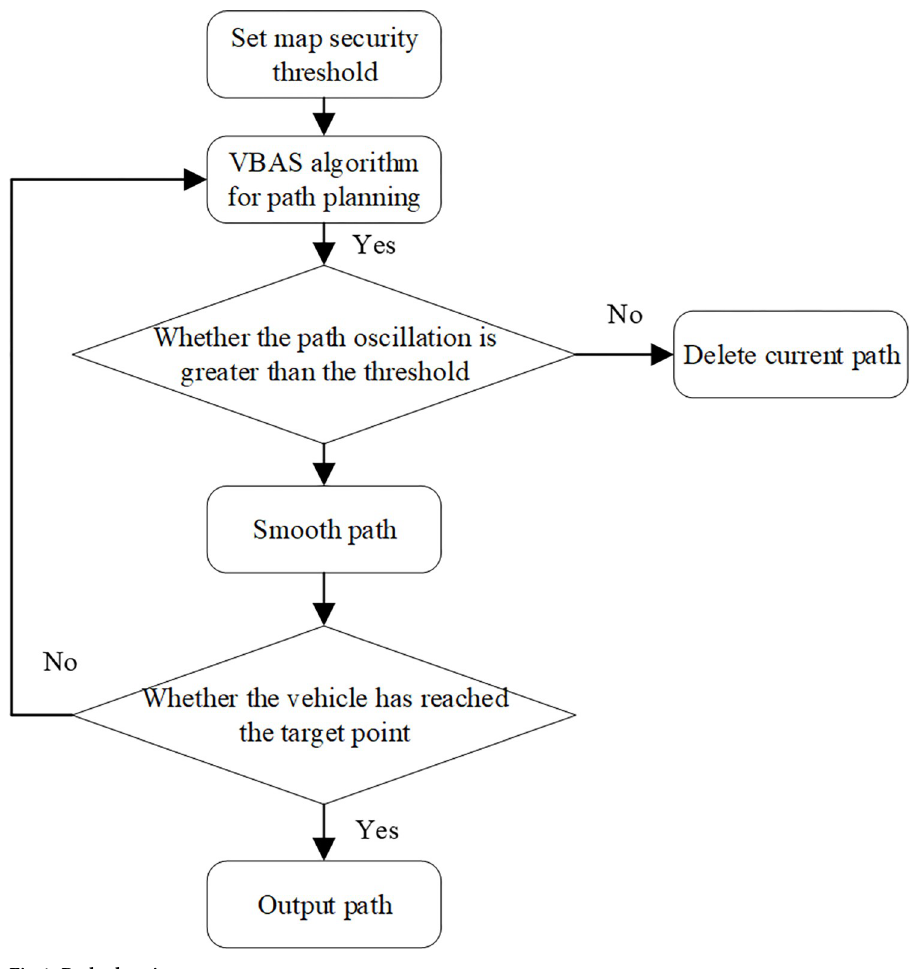
Fig 4. Path planning